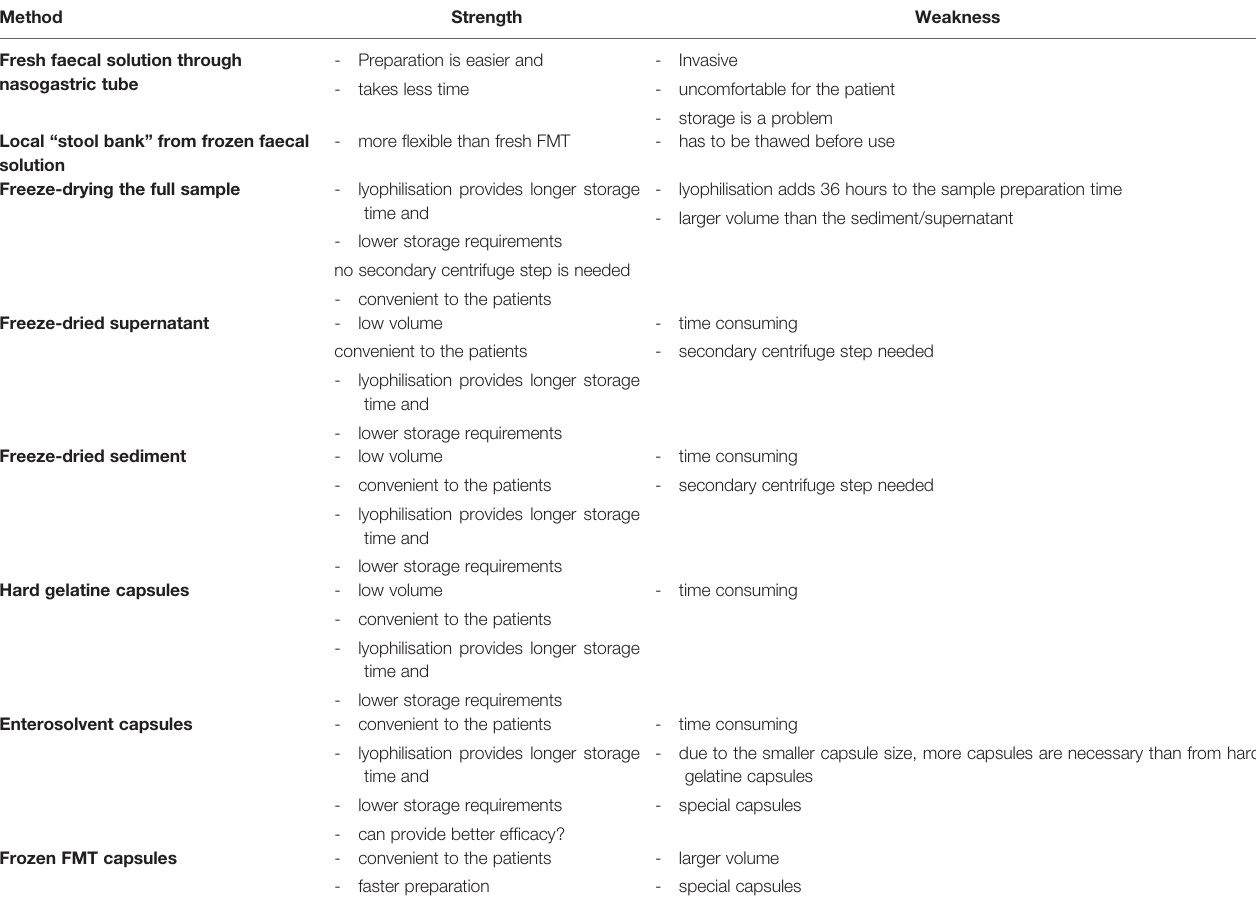
TABLE 4 | Analysis of administration modalities for faecal